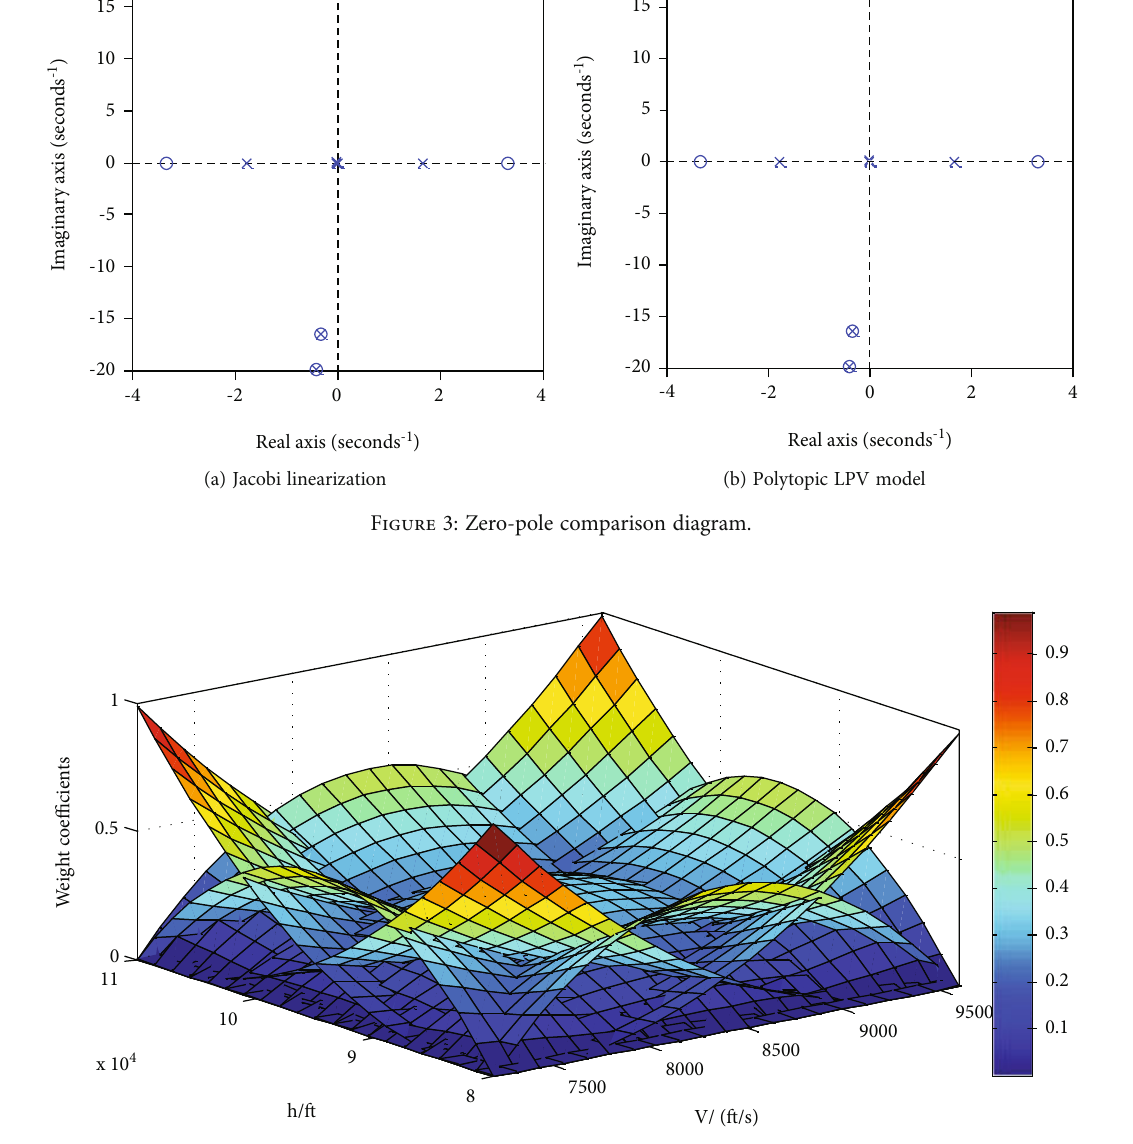
Figure 4: Time-varying weight